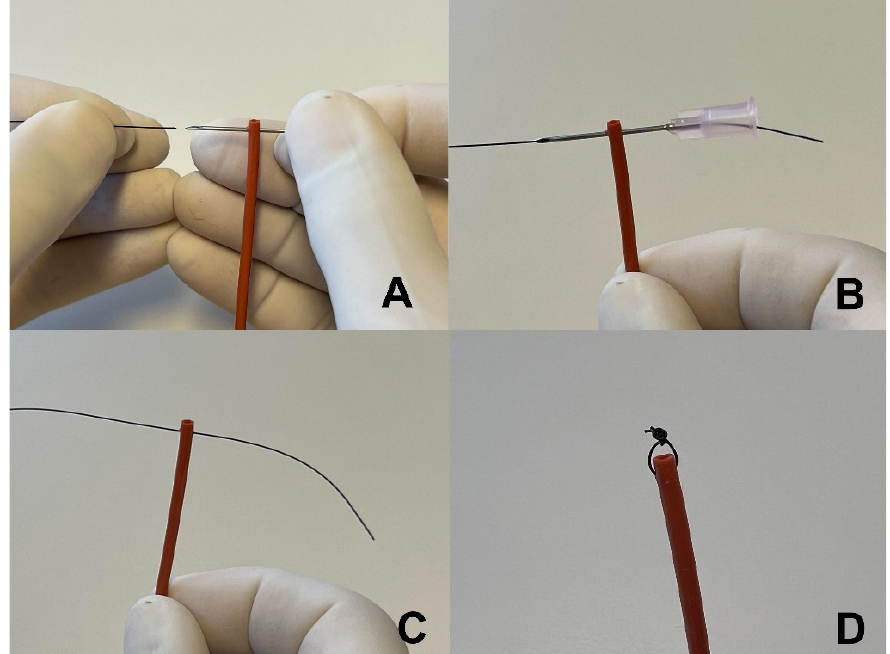
Figure 1. Construction of a temporary stent: ( A ) A hypodermic needle is inserted through the distal end of the stent and a suture is inserted into the end of the needle. ( B ) The suture is passed all the way through the hypodermic needle until it exits the needle’s hub. ( C ) The needle is retracted, leaving the suture in the needle’s track. ( D ) The suture is tied to create a small loop at the distal end of the stent. Under deep sedation or general anesthesia, the dog was placed in lateral